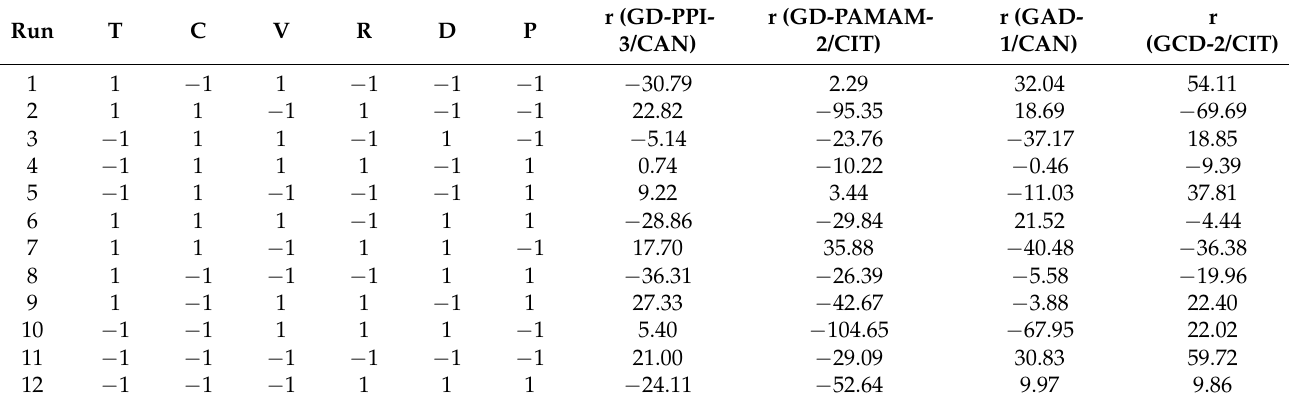
Table 2. Experimental setting (12 runs) generated by Minitab ® 19 and retention rate for the fourth combinations of dendrimers and essential oils (Eos) (%,